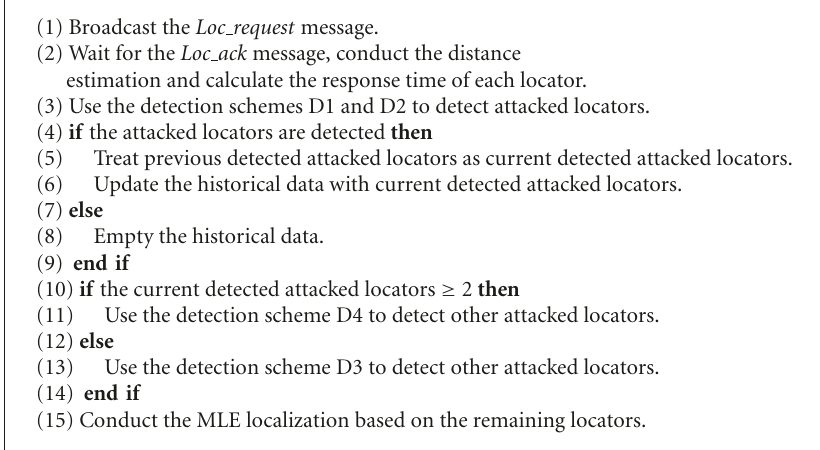
Algorithm 3: Mobility-aided TSCD secure localization scheme.